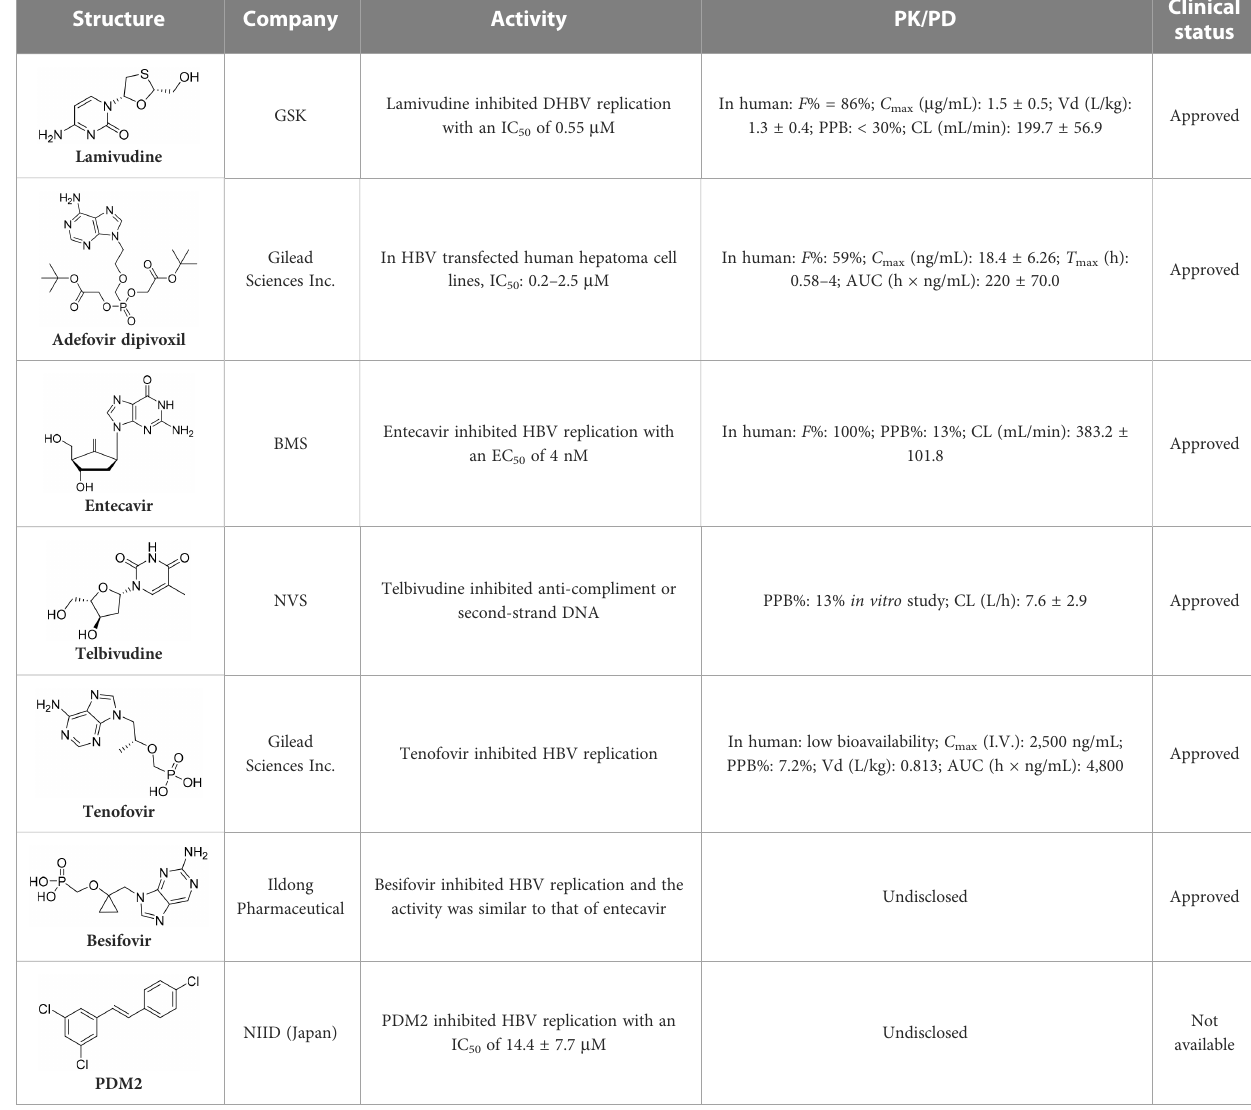
TABLE 5 The summary of NAs.